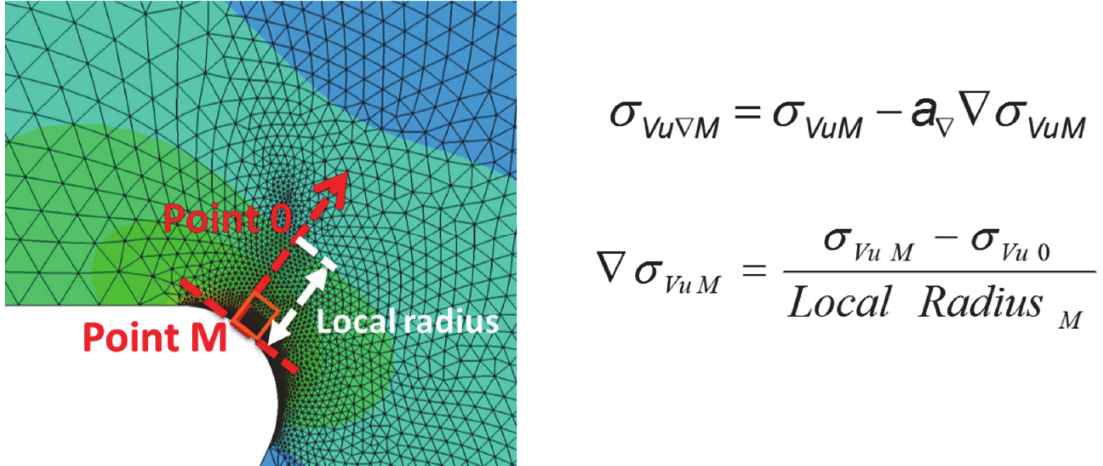
Figure 7: Measurement of the stress gradient related to the local geometry.